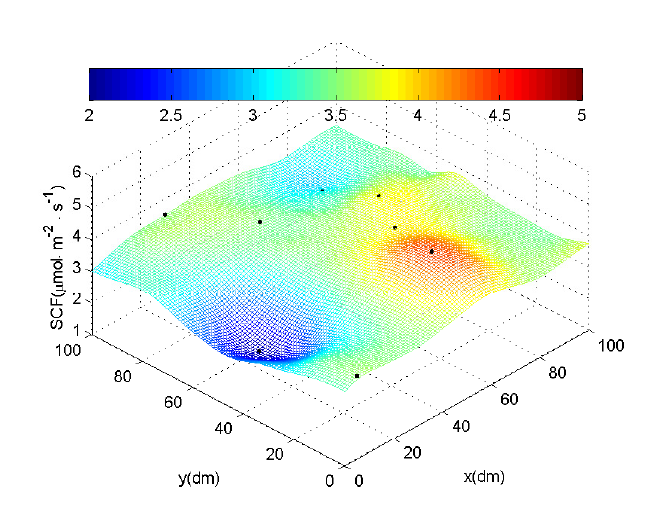
Figure 10. Results of the experimental measurements using SCFSen